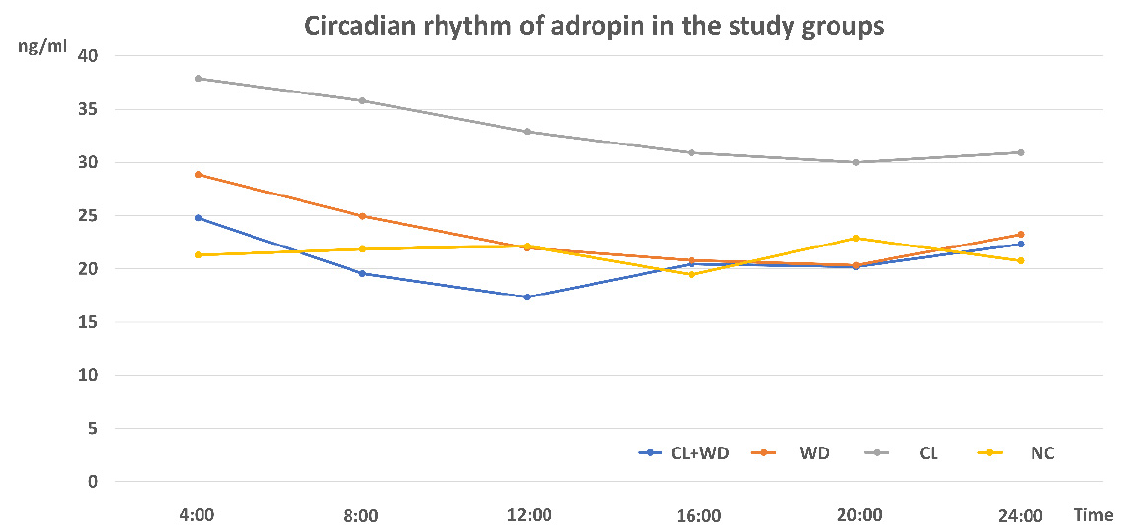
Figure 7. Circadian rhythms of plasma Adropin in different study groups ( n = 3/group).